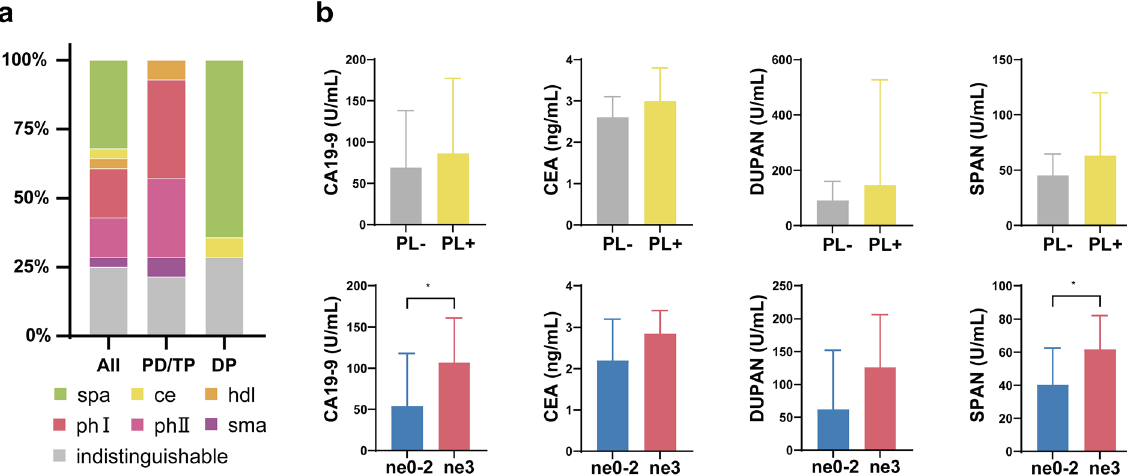
Figure 1. ( a ) The invasive sites of the extrapancreatic nerve plexus. Ce the celiac plexus, DP distal pancreatectomy, hdl the hepatoduodenal ligament nerve plexus, PD pancreatoduodenectomy, phI the pancreatic head nerve plexus I, phII the pancreatic head nerve plexus II, sma the superior mesenteric nerve plexus, spa the splenic artery nerve plexus, TP total pancreatectomy. ( b ) Comparison of tumor biomarkers. CA19-9 carbohydrate antigen 19-9, CEA carcinoembryonic antigen, DUPAN duke pancreatic monoclonal antigen, ne nerve invasion, PL extrapancreatic nerve plexus invasion, SPAN s-pancreas antigen. “*” indicates significance at P <